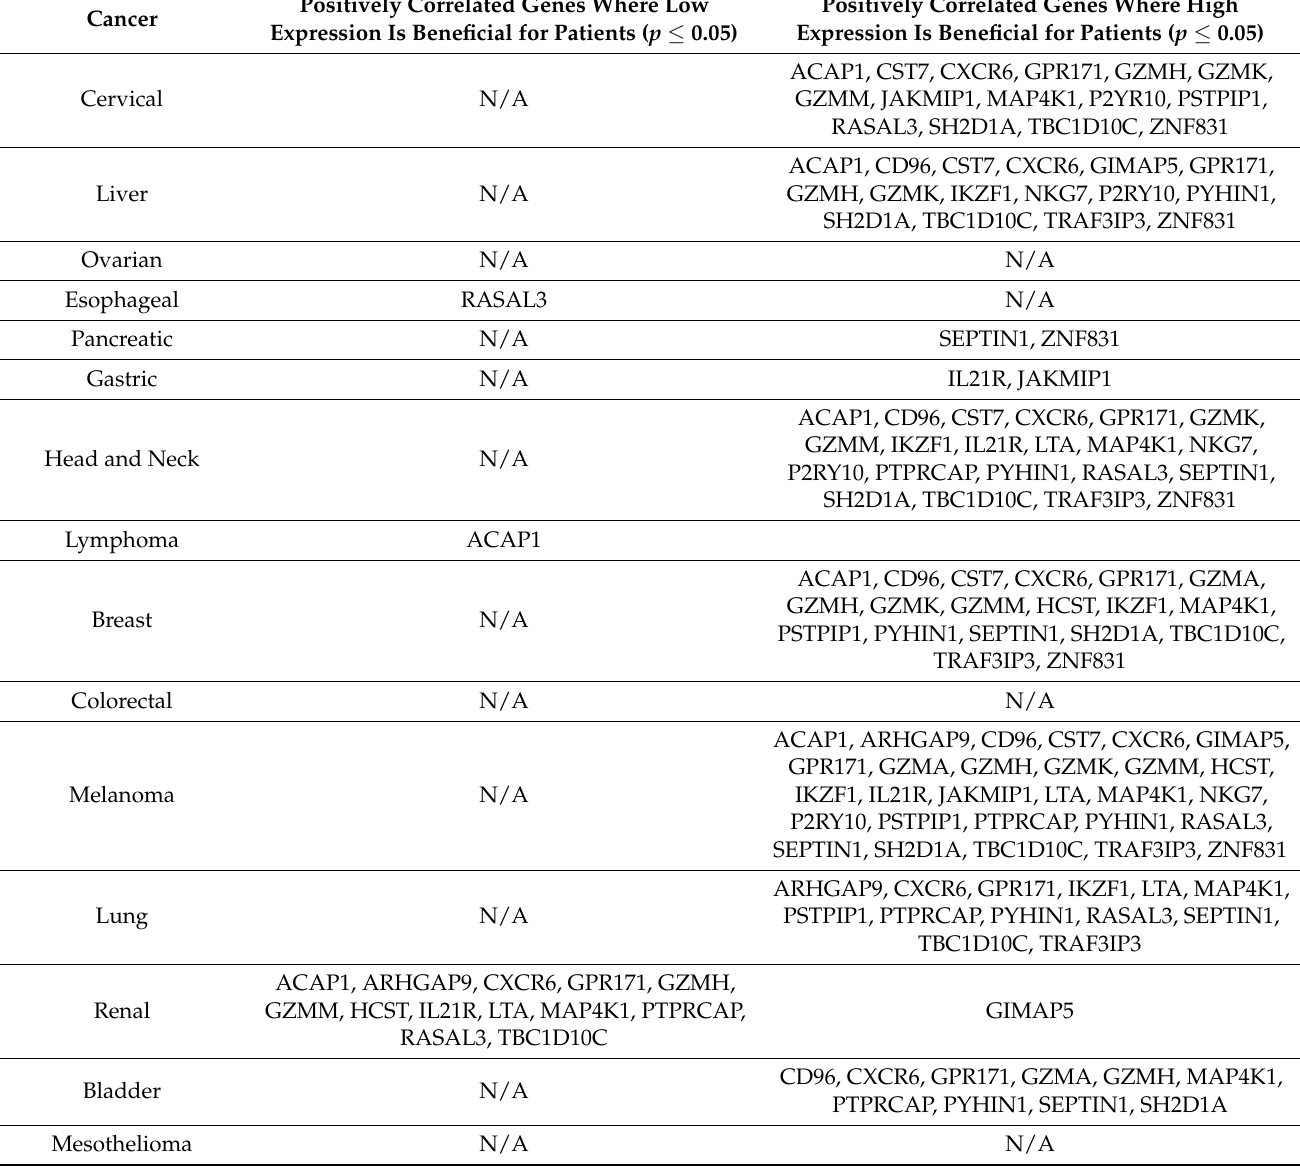
Table 3. Statistically significant Kaplan–Meier results for genes positively correlated with PDCD1. It should be noted that the mesothelioma study included (Mesothelioma (TCGA, Firehose Legacy)) lacked usable Kaplan–Meier survival data. Positively Correlated Genes Where Low Positively Correlated Genes Where High Cancer Expression Is Beneficial for Patients ( p ≤ 0.05) Expression Is Beneficial for Patients ( p ≤